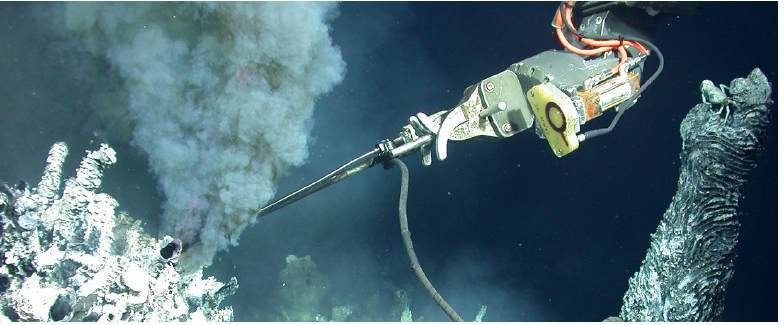
Figure 1. NASA remotely operated vehicle sampling deep sea black smokers [1]. Image used for educational purposes in accordance with NASA Media Usage Guidelines [22].